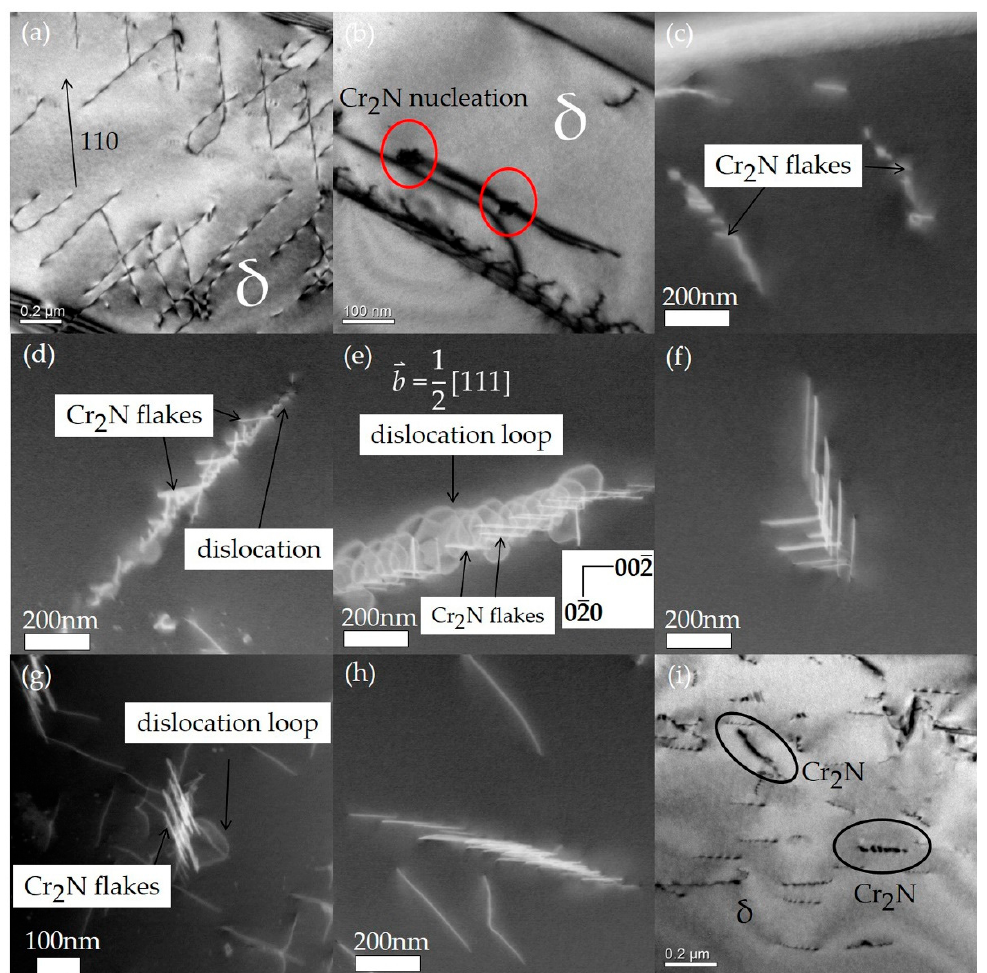
Figure 4. The sequence of the Cr 2 N nucleation and growth mechanism at 600 °C. ( a ) 5 min for only lattice defects of dislocation, ( b , c ) 10 min for Cr 2 N nucleated at dislocations, ( d – h ) 30 min for Cr 2 N flakes either stacked mutually perpendicular or stacked parallel together, ( i ) 7 h for Cr 2 N flakes coalescence.